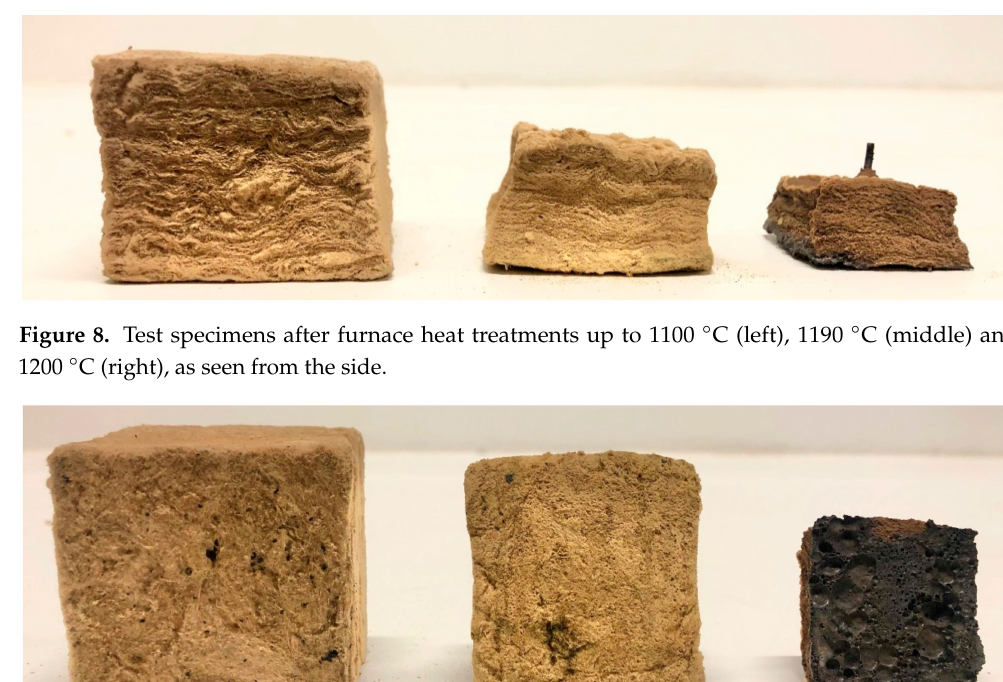
Figure 7. Virgin test specimen (50 mm cube) (left) and heat-treated to 1200 ◦ C (right), including the thermocouple that had to be cut when the specimen was removed from the furnace.